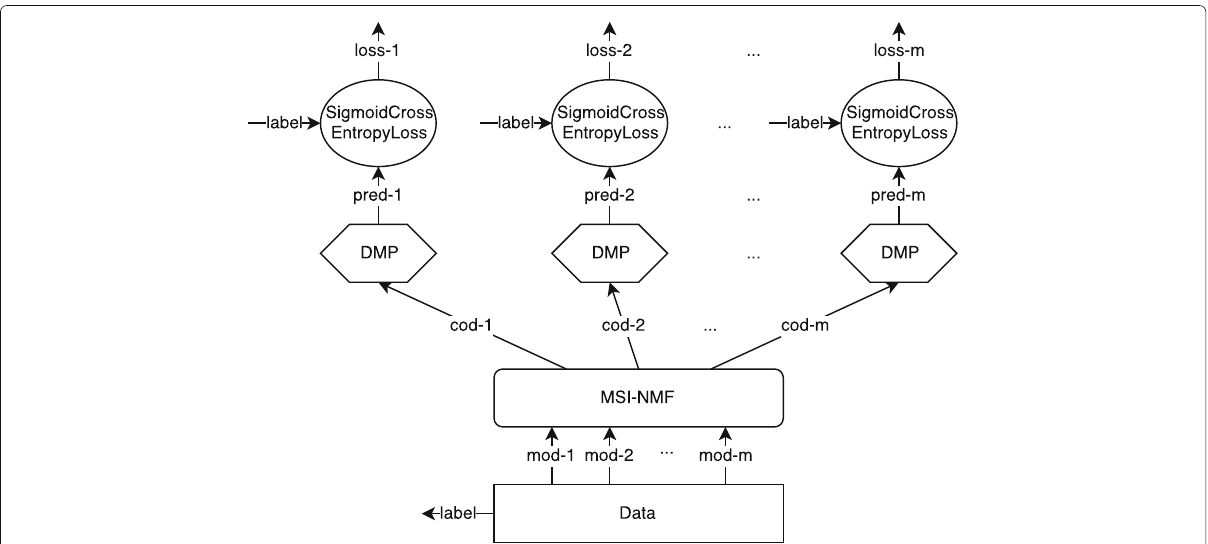
Fig. 1 Training structure of MPENet. Following Caffe terminology, this figure shows the computation graph of training phase. Arrows indicate blobs; rectangles and ellipses indicate Caffe built-in computation and loss layers. Hexagons indicate layer collections. Rounded rectangles indicate our implemented layers. All built-in layer names conform to Caffe. More details are explained in Sections 3 and 4. Repeated elements of each modality are omitted by dashed lines